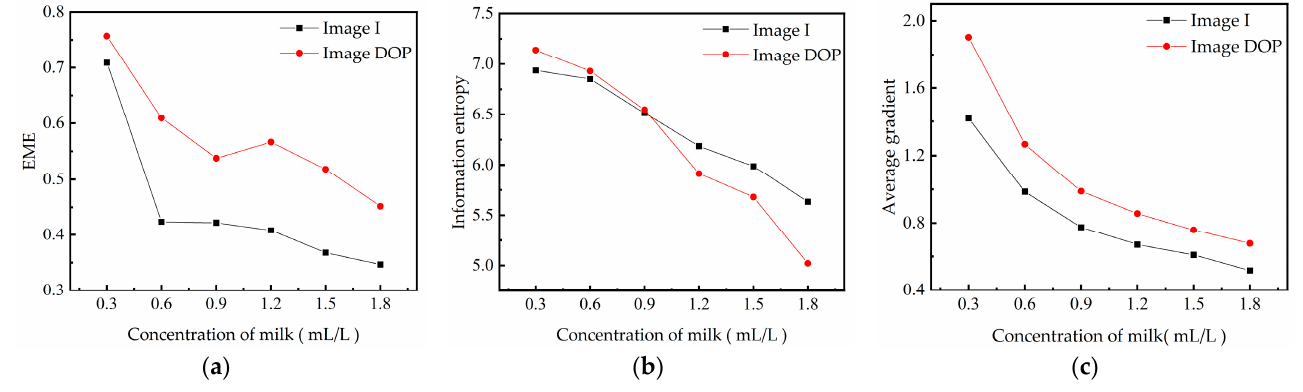
Figure 14. Image quality evaluation results of different milk concentrations: ( a ) EME; ( b ) information entropy; ( c ) average gradient.